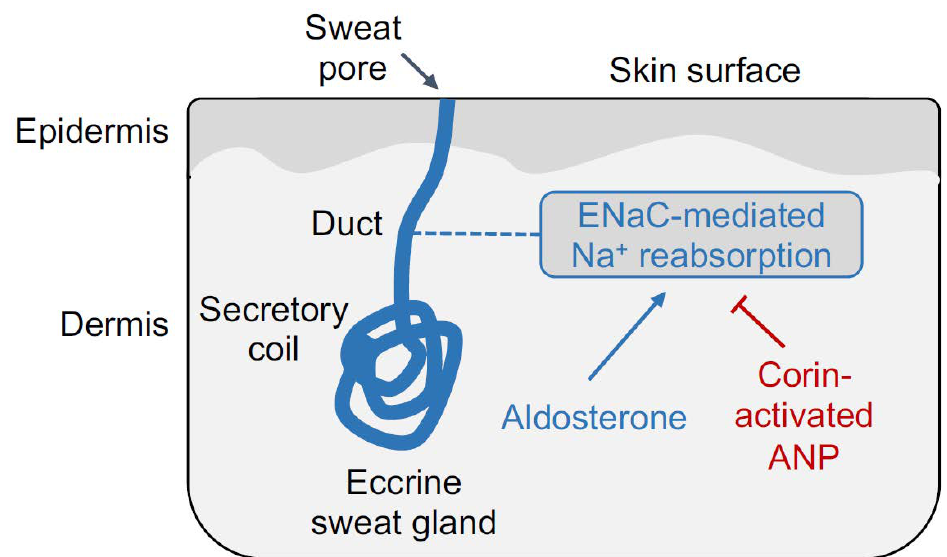
Figure 3. A proposed role of corin and ANP in the eccrine sweat gland. The eccrine sweat gland in the skin consists of the secretory coil, where initial sweat is produced, and the duct, where ENaC- mediated Na + reabsorption occurs. Aldosterone promotes ENaC-mediated Na + reabsorption. In contrast, corin and ANP inhibit ENaC-mediated Na + reabsorption, thereby increasing Na + and sweat excretion.